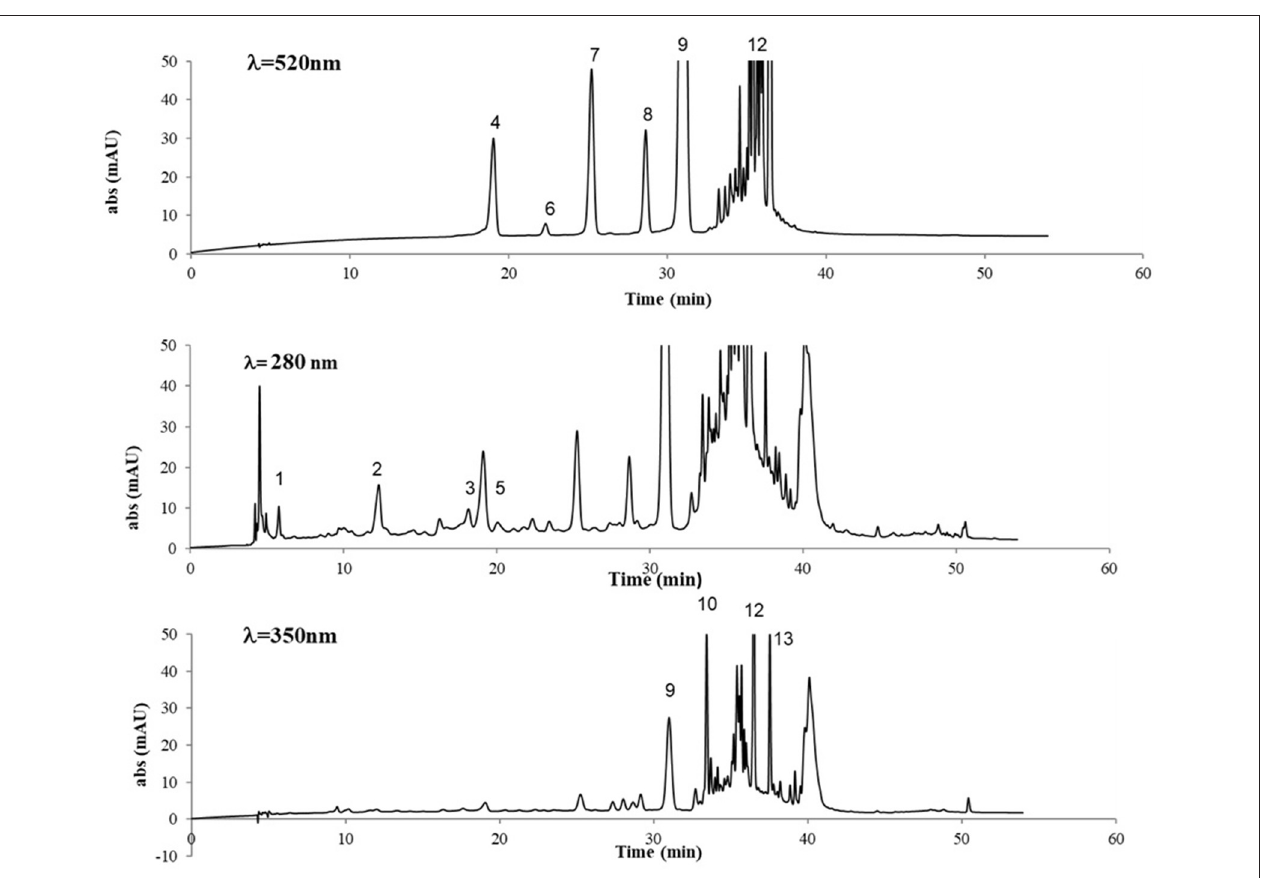
FIGURE 3 | HPLC separation of phenolic compounds in GP extract ( V. vinifera L., cv Nero di Troia), at λ = 520, 280, and 350nm. For peak assignment, see Table 2 .